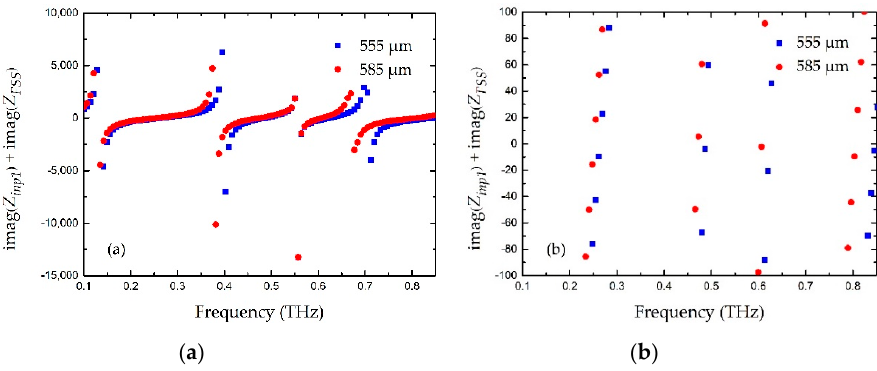
Figure 4. ( a ) The sum of the imaginary parts of Z inp1 and Z FSS ; ( b ) the enlarged view at the sum equal to zero.